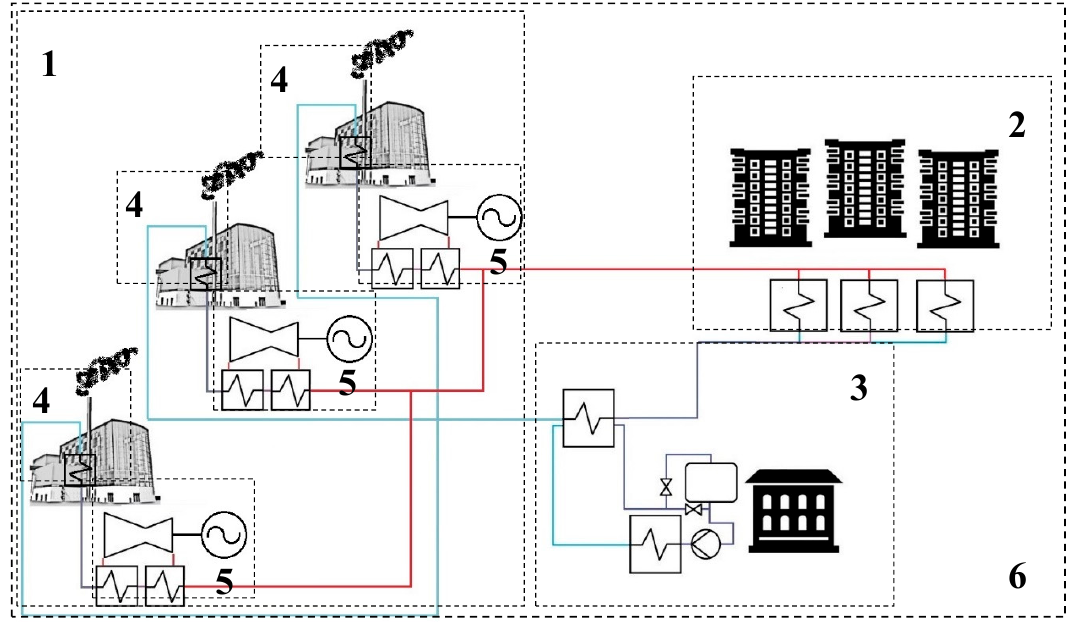
Figure 3. Illustration of a district heating system with controllable low-grade heat customers: (1) CHP power plants; (2) traditional heat load—DH substations in parallel; (3) low-grade heat customers; (4) temperature-dependent flue gas condenser (FGC); (5) temperature-dependent steam turbine; (6) studied system with boundary connections to fuel and electricity market.